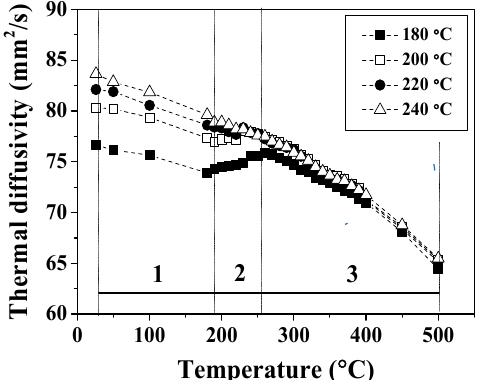
Figure 6. The precipitation of Mg 2 Si phase in Al-1.9Mg 2 Si alloy: ( a ) scanning electron microscope (SEM ) photograph after aging treatment at 180 °C for 5 h; ( b ) transmission electron microscope (TEM) photograph after aging treatment at 180 °C for 5 h; ( c ) optical microscope (OM) photograph after aging treatment at 240 °C for 5 h; and ( d ) OM photograph after aging treatment at 340 °C for 5 h.